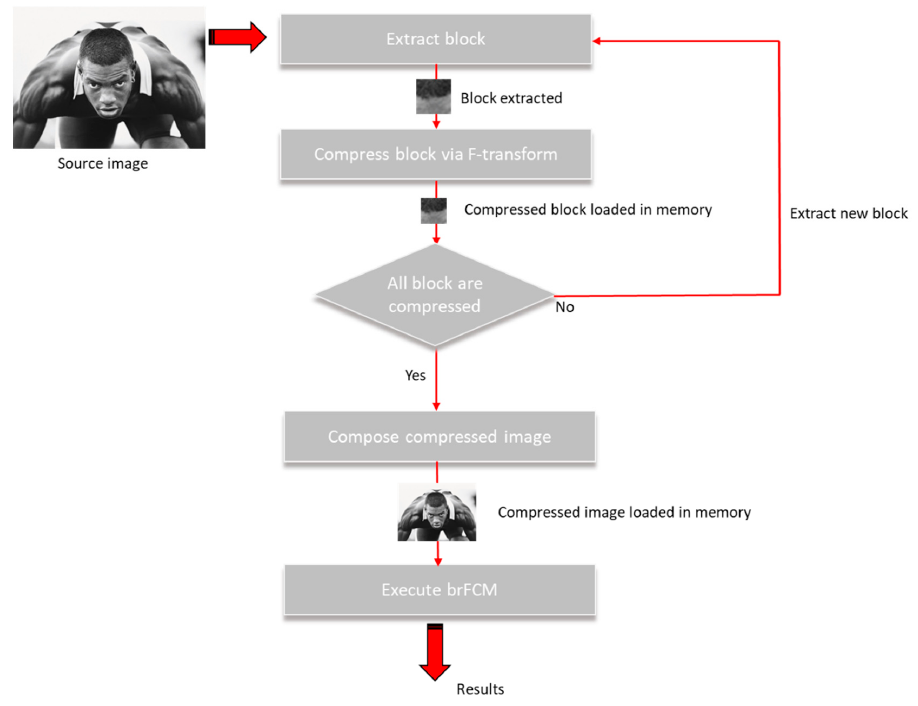
Figure 1. Schema of the image bit reduction fuzzy c-means (FCM) clustering algorithm (FTbrFCM). After the compressed image is constructed merging adjoint compressed blocks, the brFCM algorithm is executed aggregating in a bin identical adjoint pixels and then running the weighted FCM in which the weight of a bin is given by the number of pixels aggregated in it.